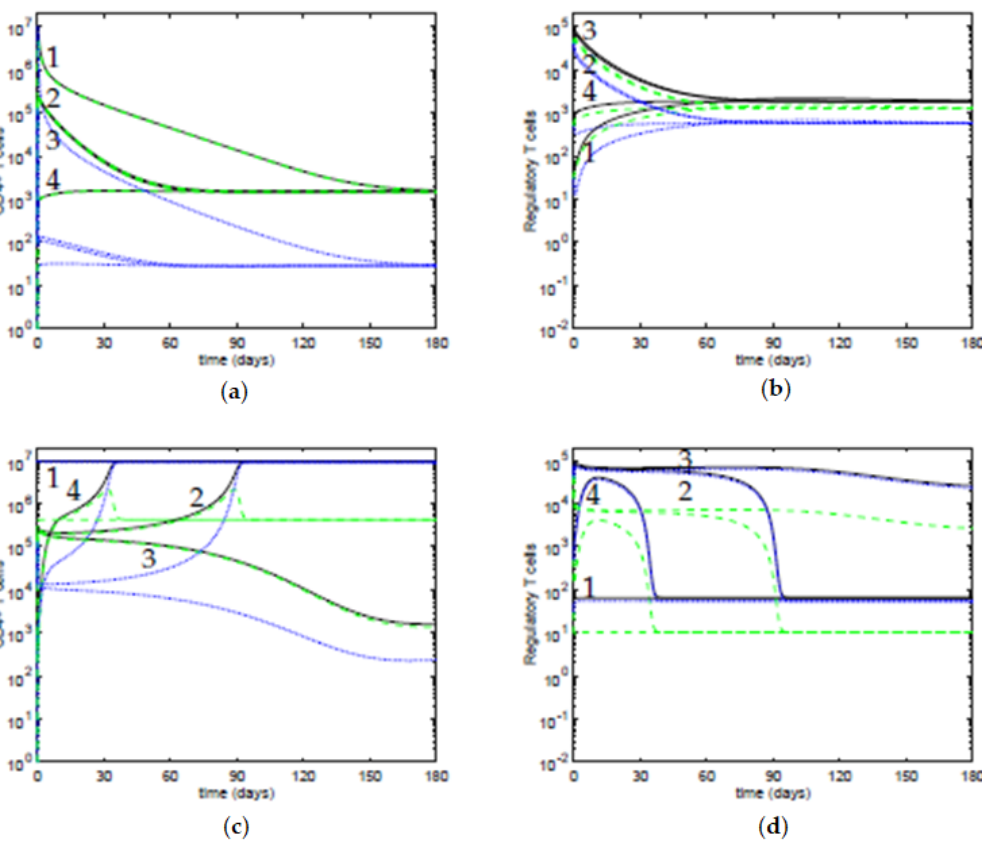
Figure 5. Time evolutions for two sets of values of the parameters and four initial conditions (see Table 2). ( a , b ) b = 10 − 1 and m = 0.2765. Here, the only stable steady state is the controlled state. ( c , d ) b = 30 and m = 0.2765. In this case, there are two stable steady states. ( a , c ) black solid lines—total concentration of T cells x ; blue dots—concentration of secreting T cells T ∗ ; green dashes—concentration of non-secreting T cells T . ( b , d ) black solid lines—total concentration of Tregs y ; blue dots—concentration of active Tregs R ∗ ; green dashes—concentration of inactive Tregs R